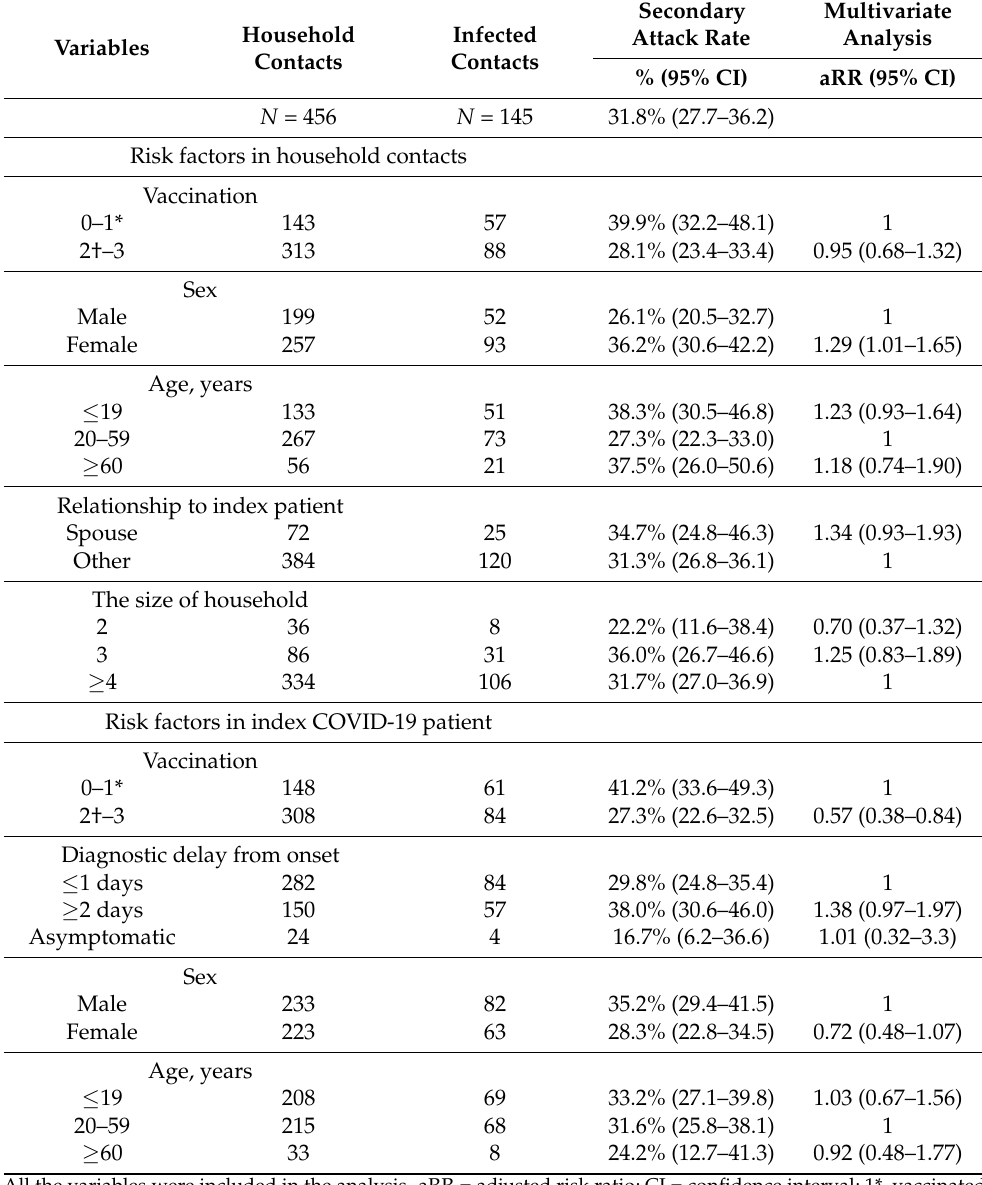
Table 3. Secondary attack rates among the household contacts of COVID-19 patients during the omicron variant-dominant